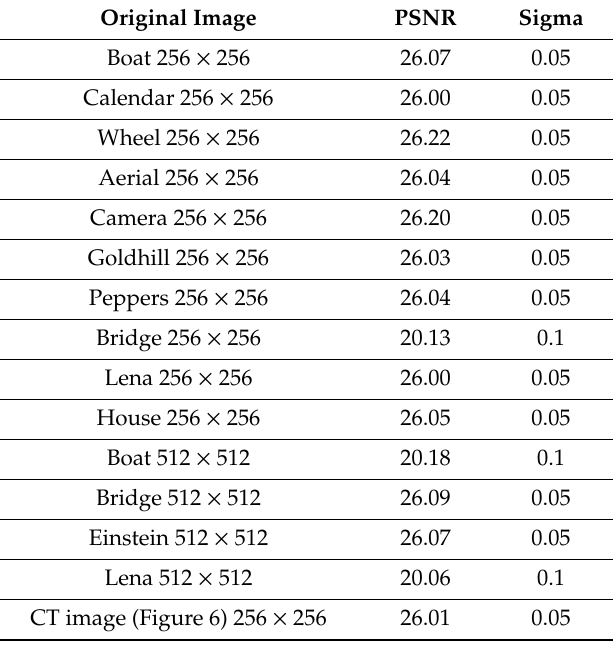
Table 1. The input images used in the algorithm and their peak signal to noise ratios (PSNR) and Sigma